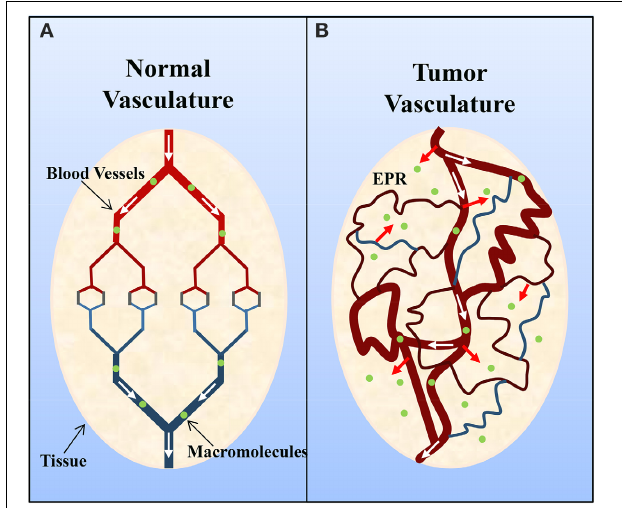
FIGURE 2 | Schematicrepresentationof(A)normaland(B)tumorvascu- lature. Normaltissueiscomposedofmature,organizedbloodvessels,while tumor tissue consists of immature, leaky and tortuous vessels. The altered organizationoftumorvasculatureanddisorganizedlymphaticnetworkresults invascularleakageandtheaccumulationofmacromolecules( > 40kDa)within the interstitium and is known as the enhanced permeation and retention (EPR) effect. Adapted by permission from Macmillan Publishers Ltd: Nature Medicine (Jain, 2001), copyright (2001).